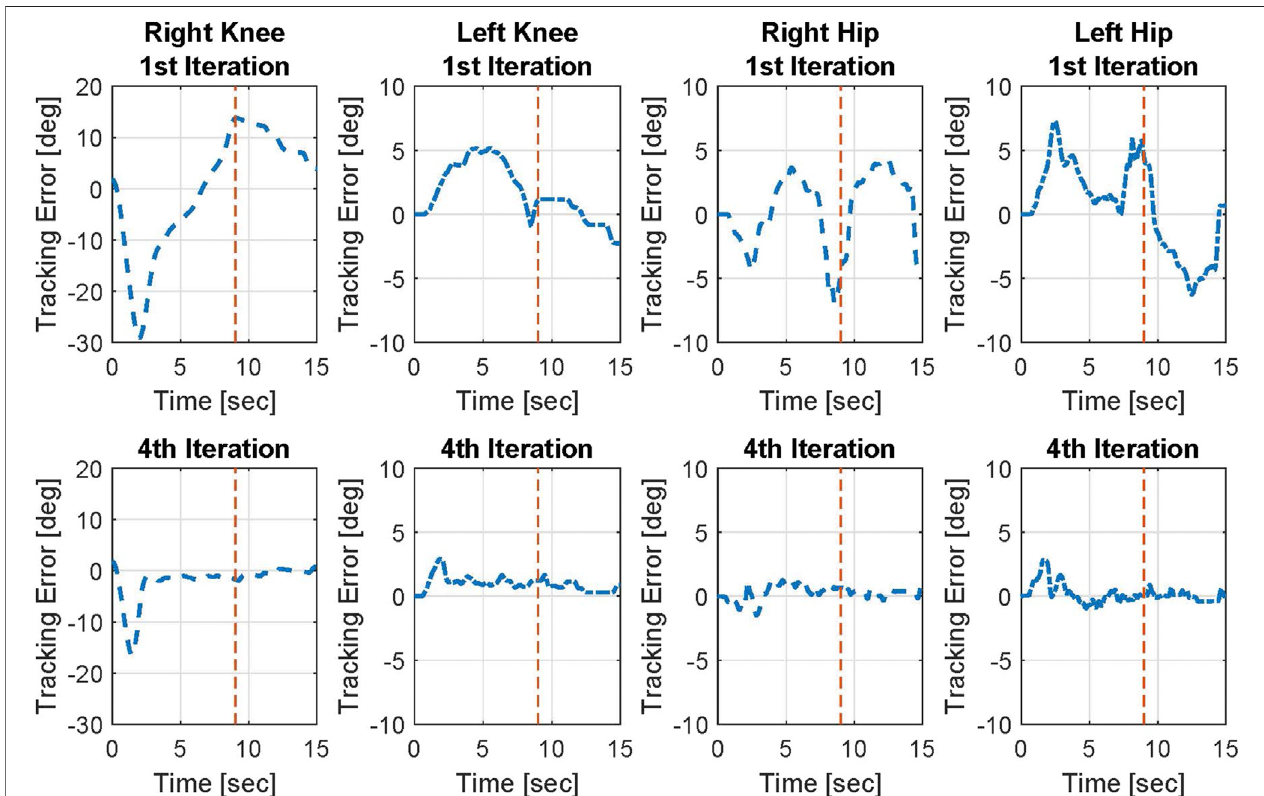
FIGURE4| AngularpositiontrackingerrorsonbothkneeandhipjointsofParticipant2inthe1stand4thiterations.Reddashedlineshowstheapproximatetimein which the sit-to-stand movement is mainly done.